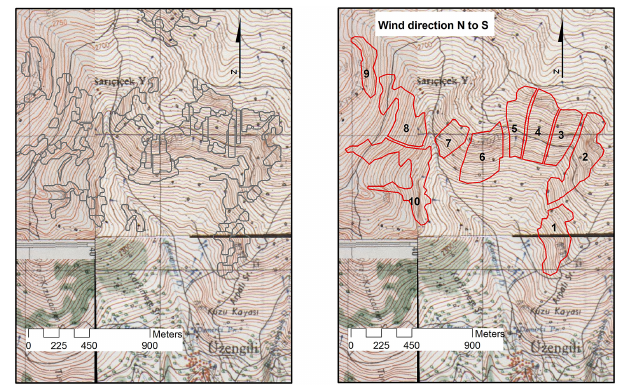
Fig. 6. Identified release zones by DEM-based release zone genera- tion approach (left); corrected release zones to use in simulations at Üzengili (right) with a DEM resample of 10m, a curvature thresh- old of 3 and a roughness threshold of 0.03.